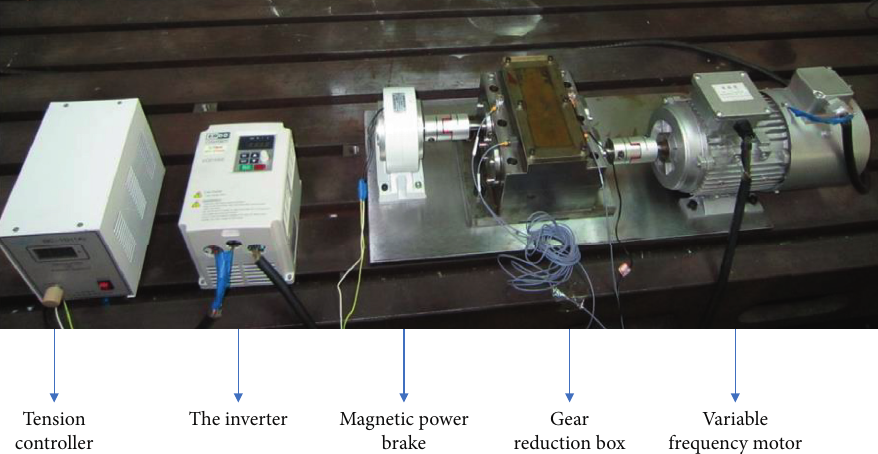
Figure 12: The test rig of experiment